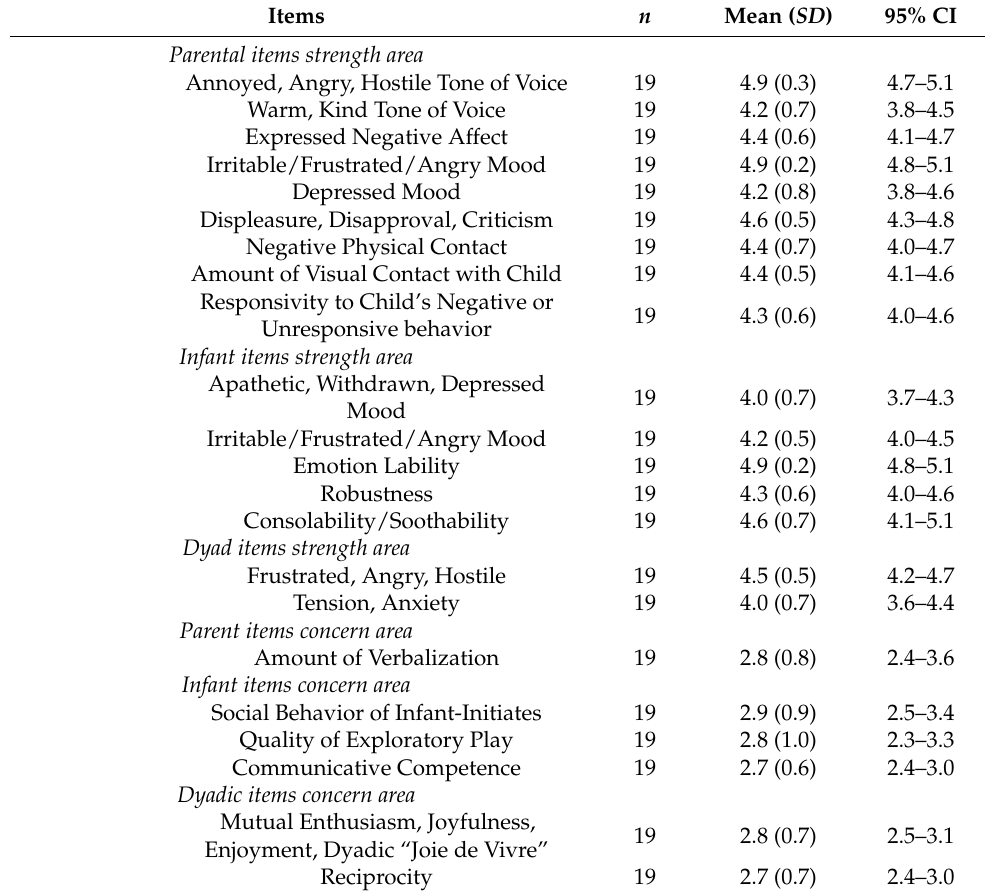
Table 5. The Parent–Child Early Relational Assessment items mean scores in the strength and concern